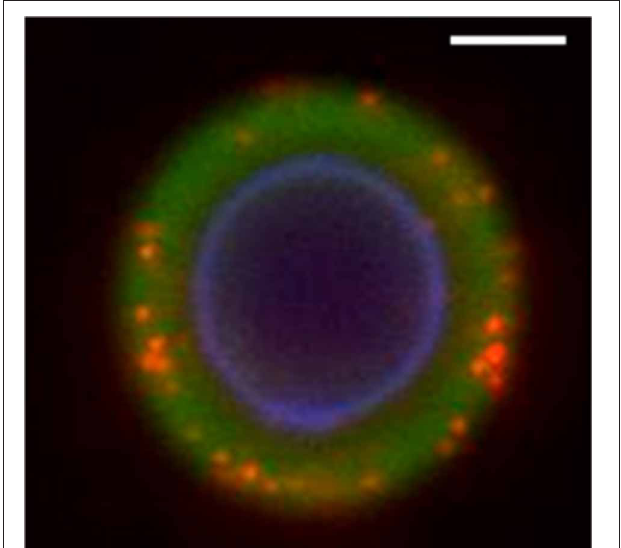
FIGURE 2 | Fluorescence microscopy of C. neoformans after staining for cell wall chitin (blue fluorescence), capsular GXM (green fluorescence) and α 1,3 glucan (red fluorescence). The capsular distribution of α 1,3 glucan suggests that the glycan is interacting with GXM and supports the hypothesis that the fungus forms hybrid polysaccharides. For experimental details, see Cordero et al. (2011). Image provided by Dr. Radames, J. B. Cordero. Scale bar, 1 μ